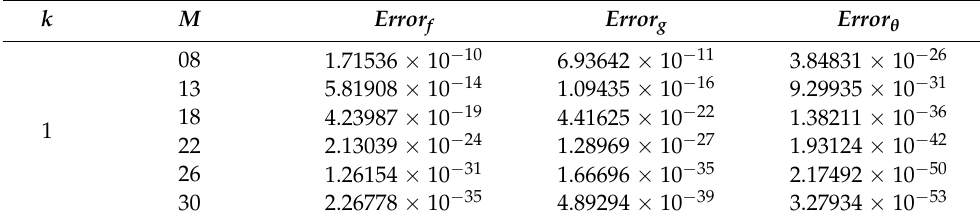
Table 2. Assessment of the projected outcomes for 𝑓 (cid:4593)(cid:4593) (cid:4666)0(cid:4667) and 𝑔 (cid:4593) (cid:4666)0(cid:4667) with existing results [44] and homotopic analysis method (HAM) [45] for 𝜙 = 𝐴 (cid:2869) = 𝐴 (cid:2870) = 0, 𝑅𝑒 = 1 and for different values of 𝛺 .